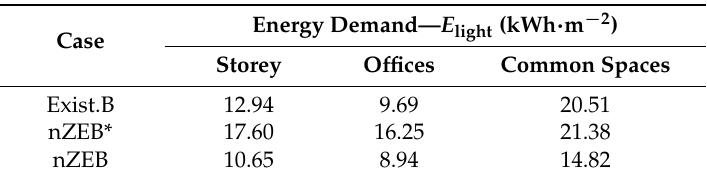
Table 9. Energy demand for the electric lighting system.